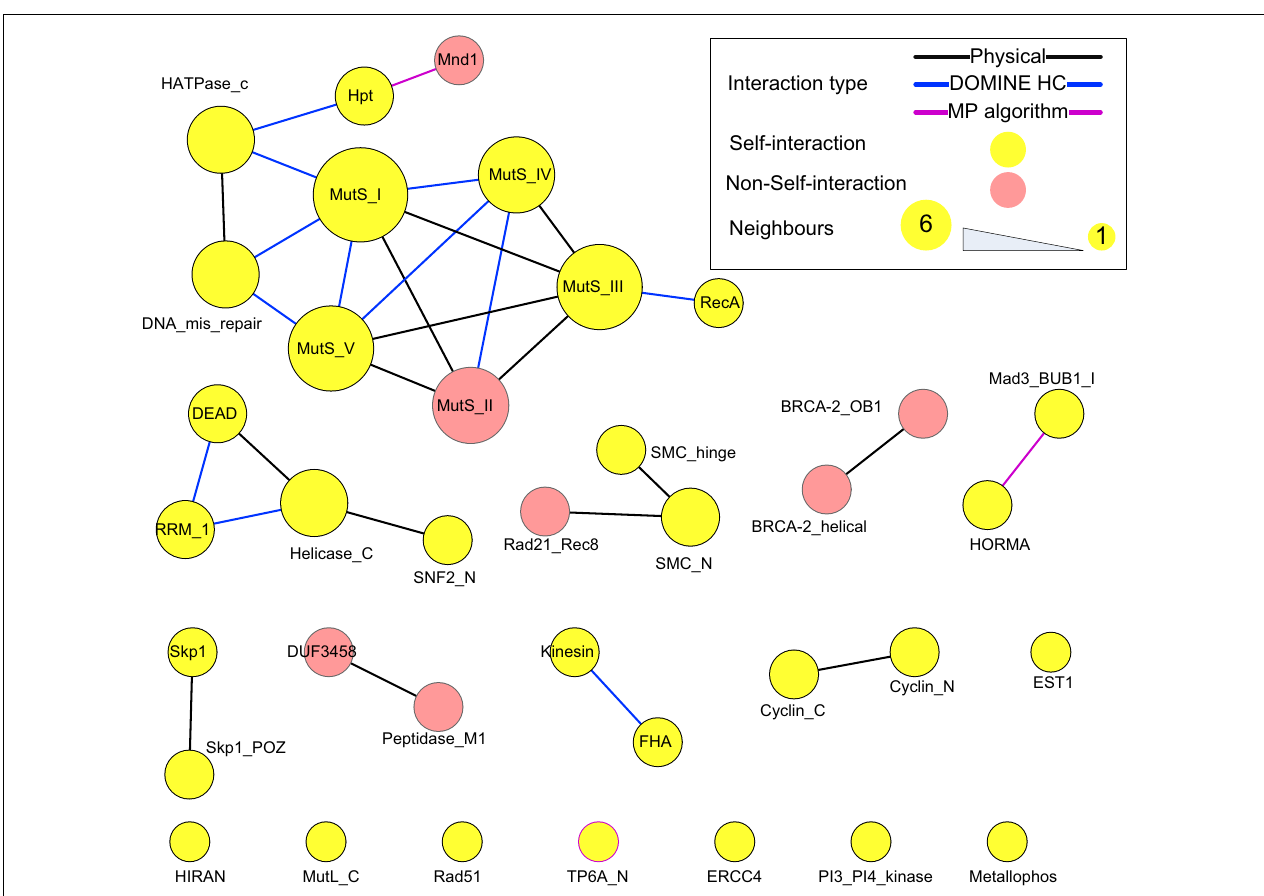
FIGURE 10 | Domain interactions contained in the putative meiotic network. Types of “evidence” were shown as edge colors. Edges of self-interacting domains were omitted, but highlighted by node (and node border)